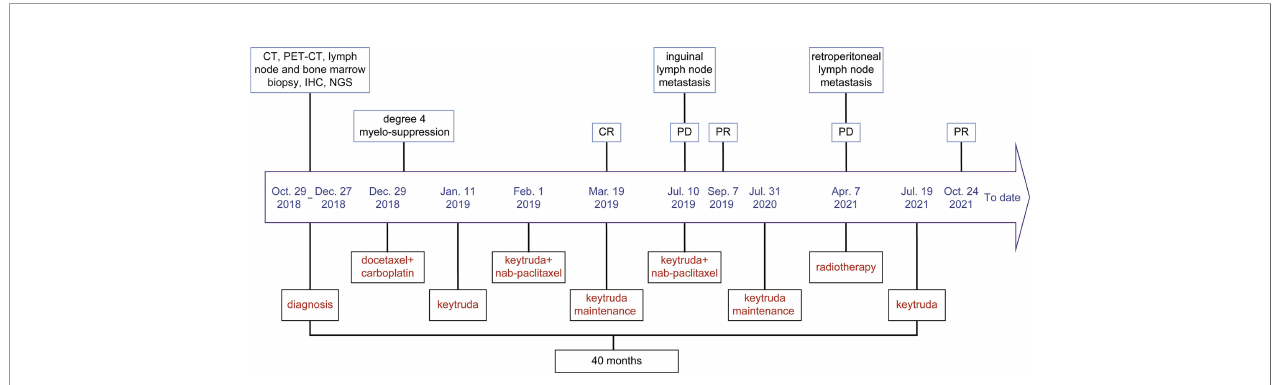
FIGURE 2 | The timeline of the treatment process for the patient. The patient has experienced immunotherapy, the combination of immunotherapy and chemotherapy, and the combination of immunotherapy and radiotherapy. At initial treatment and after two recurrences, the patient achieved clinical bene fi ts.